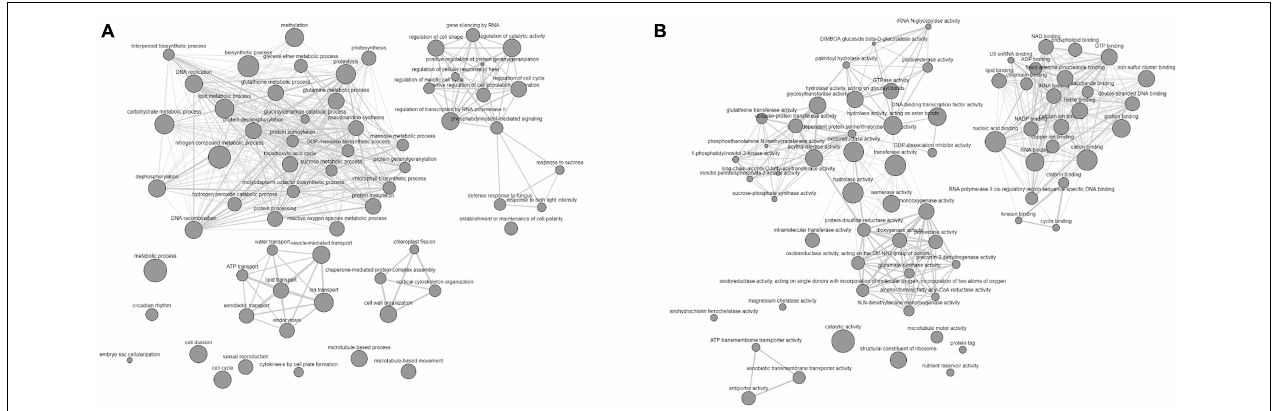
FIGURE 6 | GO enrichment-based biological (A) and molecular (B) networks of hub genes indicating the involvement of various biological and functional groups in the accumulation of WSCs in the wheat stem under differential water conditions.